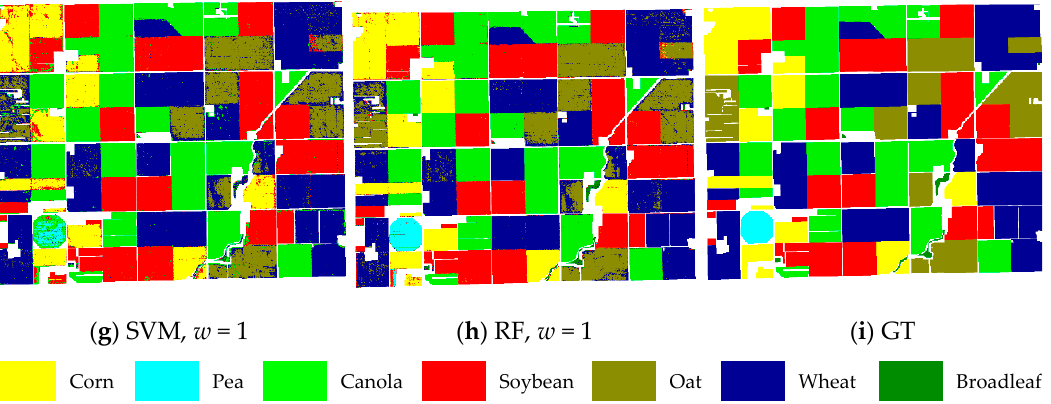
Figure 10. Classification maps obtained from ( a ) SAE, w = 1, ( b ) SAE, w = 3, ( c ) SAE, w = 5, ( d ) GFSAE, w = 1, ( e ) GFSAE, w = 3, ( f ) GFSAE, w = 5, ( g ) SVM, w = 1, ( h ) RF, w = 1, and ( i ) the ground reference map for the Winnipeg dataset.